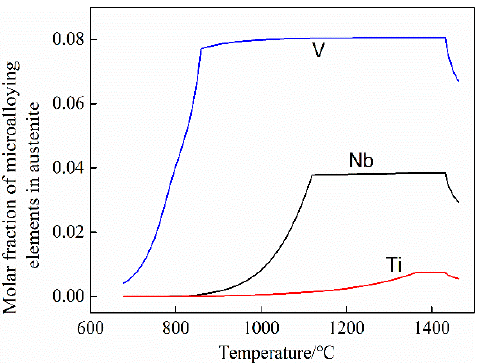
Figure 1. Calculated solution temperature of microalloying elements in austenite of test steel.